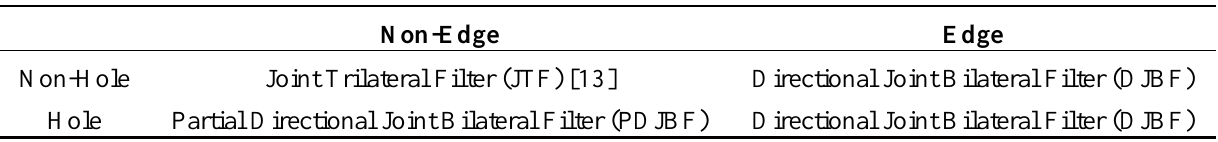
Table 1. Used filters in the proposed method